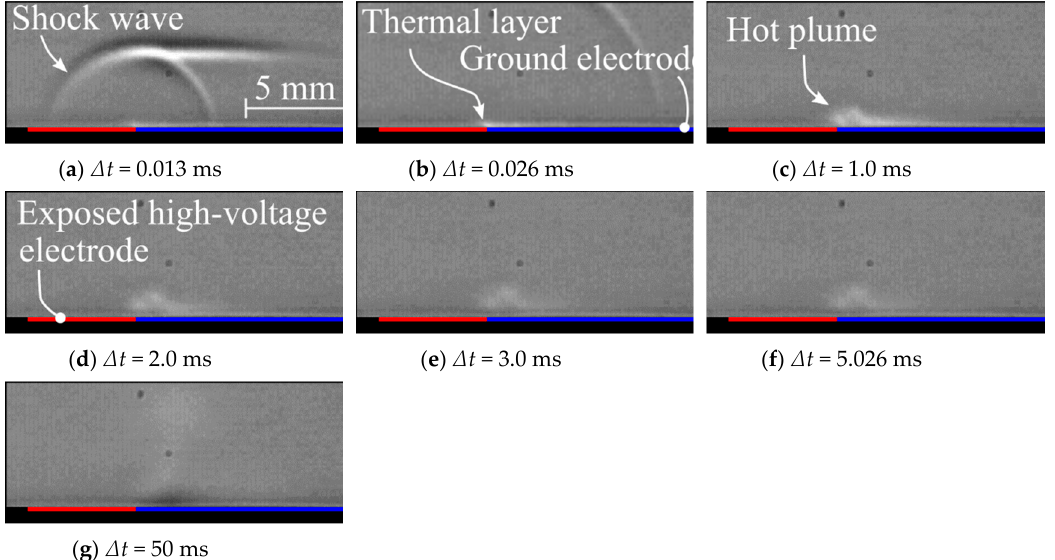
Figure 5. The thermal perturbation and the shock waves in the no-burst plasma discharge case (Case 1, Baseline).